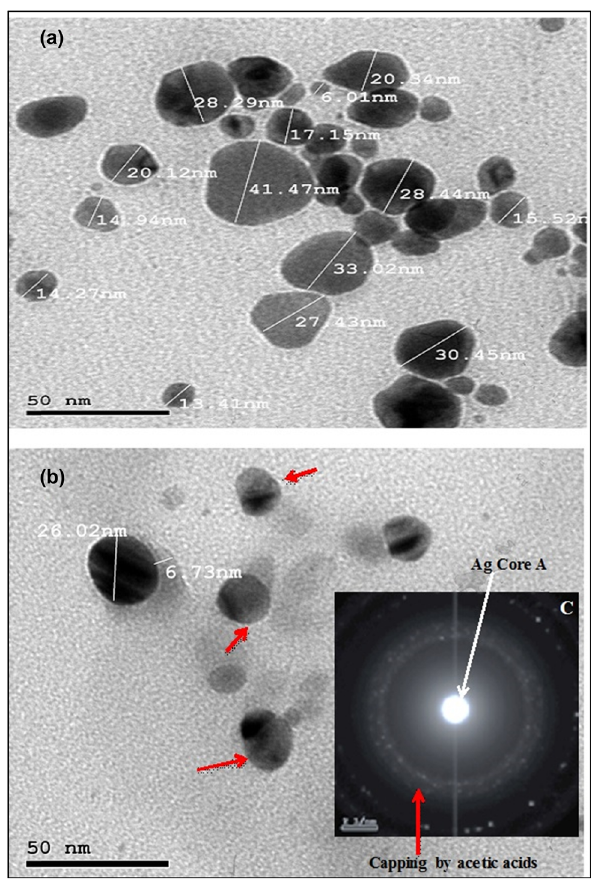
Figure 4: High - resolution transmission electron microscopy ( HR - TEM ) measurement of ( a ) biogenic AgNPs by C. elongata , ( b ) bio - synthesis AgNPs capping by acetic acid red arrows, and ( c ) AgNPs coating with acetic acid.